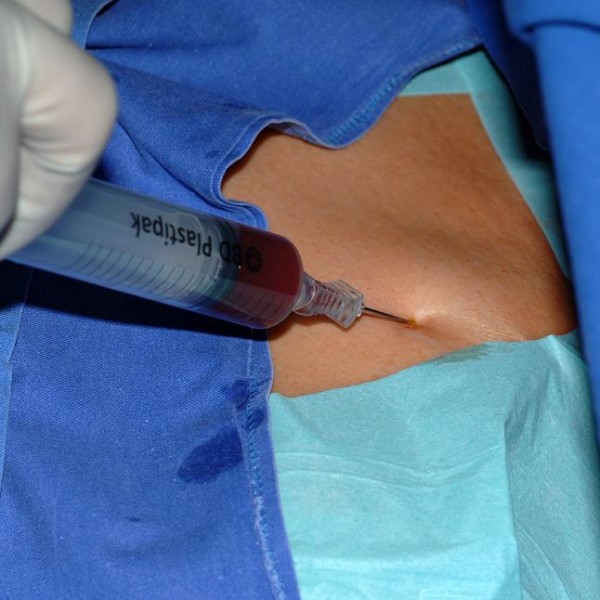
Puncture of V. Subclavia – puncture.